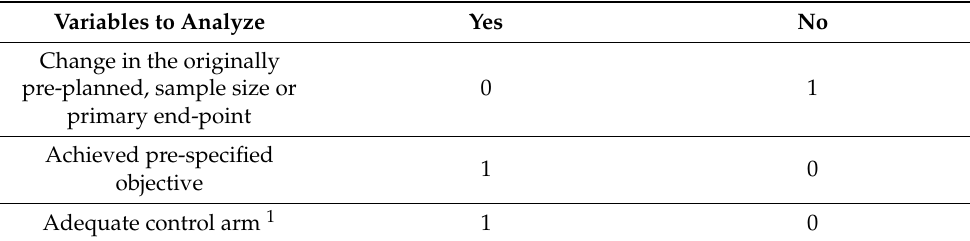
Table 1. Items for quality trial design (QTD)